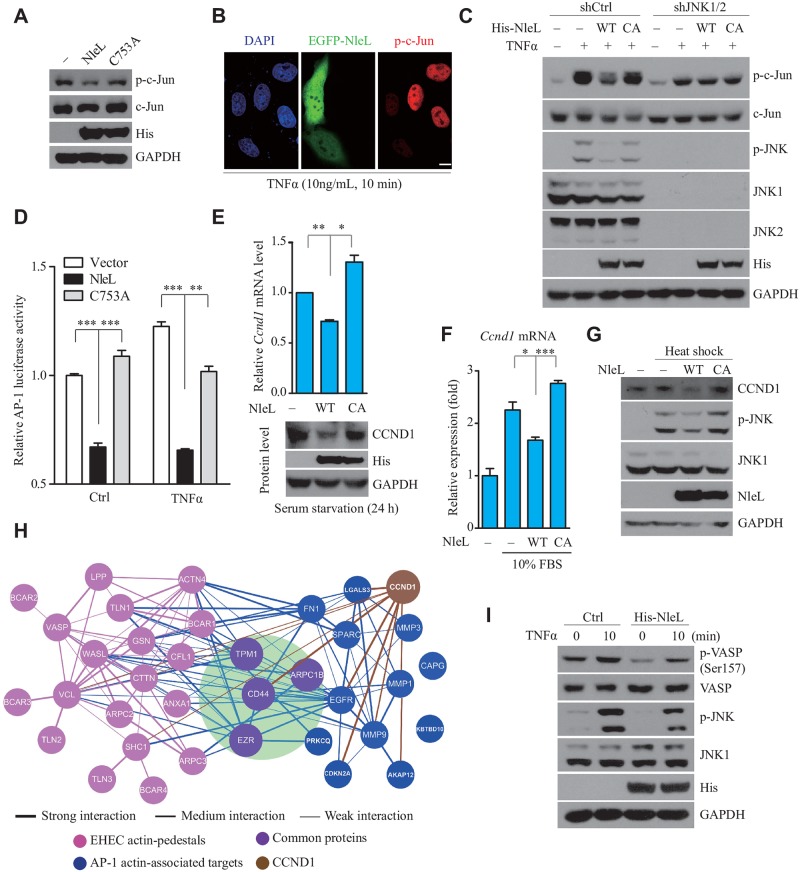
NleL-mediated JNK ubiquitylation disrupts the JNK/AP-1 signaling pathway in the mammalian cells.(A) NleL inhibited the basal-level phosphorylation of c-Jun in HEK293T cells. (B) NleL prevented the activation of endogenous c-Jun upon TNFα stimulation. Cells were transfected with EGFP-NleL for 24 h before TNFα stimulation (10 ng/ml). Immunofluorescence microscopy analysis was performed with anti-phosphorylated c-Jun antibody (p-c-Jun, in red). Nuclei were counterstained with DAPI (blue). Scale bars represent 10 μm. Shown are representative images from three independent experiments. (C)
Jnk1/2 knockdown blocked NleL-mediated inactivation of c-Jun. Cells stably expressing control shRNA (shCtrl) or shRNA for Jnk1/2 (shJNK1/2) were transfected with indicated plasmids for 24 h before TNFα stimulation (10 ng/ml, 10min). Then phosphorylation level of c-Jun and JNK were determined by IB analyses. (D) NleL suppressed the transcription factor activity of AP-1. HEK293T cells expressing wild-type NleL or its C753A mutant were co-transfected with the dual luciferase AP-1 reporter system. Twenty-four hours after transfection, the cells were stimulated by TNFα (10 ng/mL, 6 h) and then subjected to a luciferase activity assay. Data are represented as the mean ± s.d. from three biological replicates, ***P<0.001. (Student’s t-test, data from three biological replicates (n = 3)). (E) NleL down-regulated the homeostatic level of endogenous cyclin D1 (CCND1) at mRNA (upside) or protein (downside) level. Data are represented as the mean ± s.d from three biological replicates, *P < 0.05, **P < 0.01. (Student’s t-test). (F) NleL reduced 10% FBS-stimulated transcription of cyclin D1. HEK293T cells expressing NleL or C753A mutant were serum-starved for 24 h and then stimulated with 10% FBS. Then qRT-PCR was performed to determine cyclin D1 expression at mRNA level. Data are shown as the mean ± s.d. from three biological replicates, *P < 0.05, ***P < 0.001 (Student’s t-test, n = 3). (G) NleL suppressed the CCND1 expression up-regulated by heat shock. Cells expressing NleL or C753A were serum-starved for 24 h, and then subjected to heat shock (42°C, 40 min). (H) Protein-protein interactions among the actin-associated proteins targeted by transcription factor AP-1 and proteins characterized in EHEC actin pedestals (blue and pink, respectively). Hits common in both groups are shown in purple, with the interactions directly related to AP-1 targets shown in blue and the interactions only among actin-pedestal proteins in pink. And, CCND1 and its interaction are brown. Line thickness indicates the interaction level of proteins. (I) NleL regulated phosphorylation of an actin-pedestal protein VASP. HEK293T cells transfected with or without a plasmid expressing His6-tagged NleL were stimulated by TNFα (10 ng/ml, 10 min), and then subjected to IB analyses with indicated antibodies. Blots are representative of at least three independent experiments.